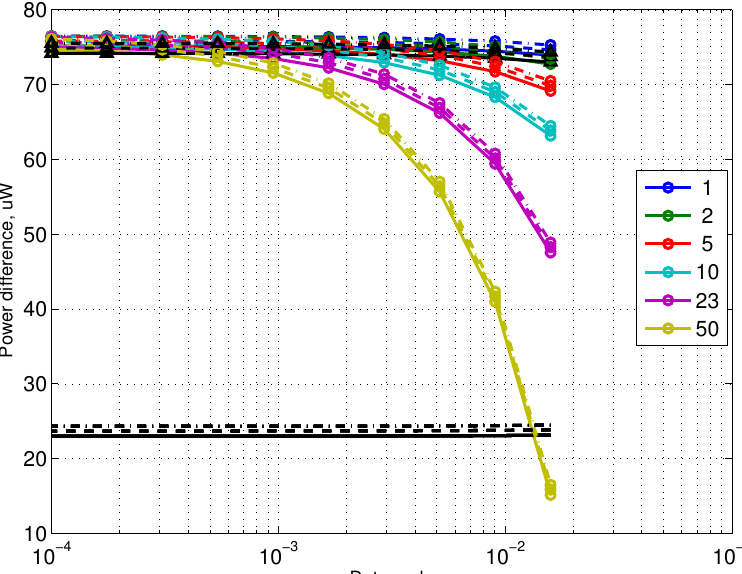
Figure 19. When M t = 1 and M r = 2, power difference while operating. Capacitor ( C s = 0.35 F). Non-WuR in black (without triangles), passive WuR in colors indicating number of nodes for different host duty cycles per node ( β (cid:48) w ). Semi-passive WuR in black with triangles. Line type indicates used SC leakage current model as —: upper , - - -: median, and -.-.-: